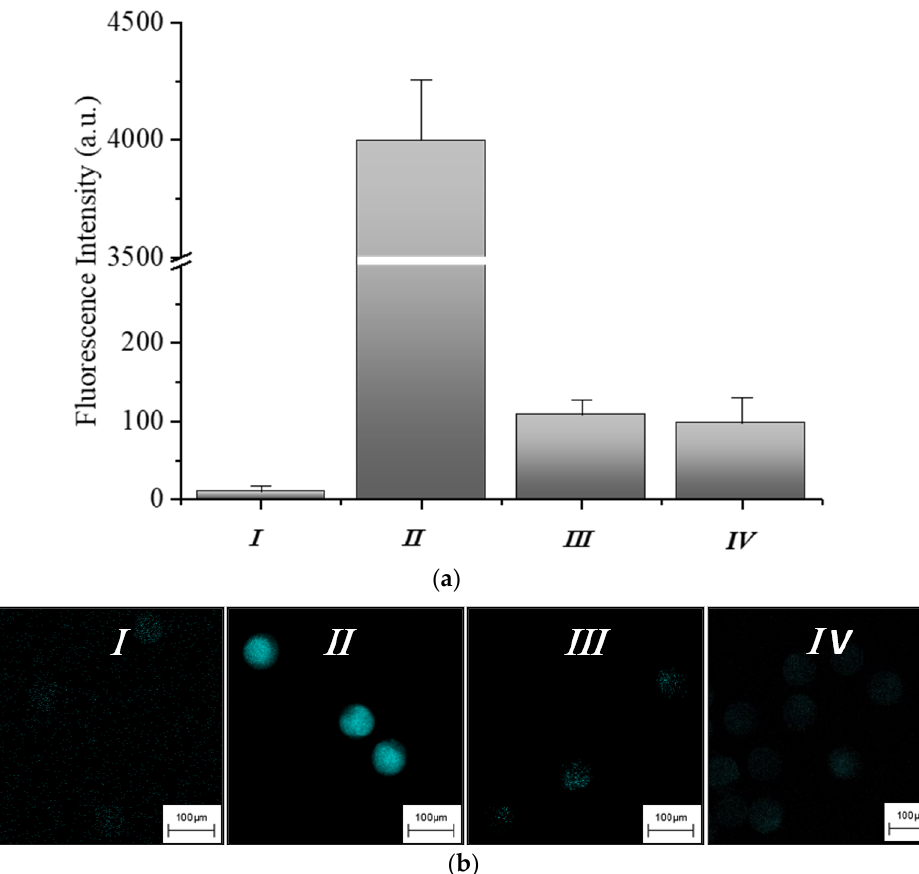
Figure 3. ( a ) Fluorescence intensity measured during the hydrogel-based assay setup and ( b ) the corresponding CLSM images. In particular, the figure shows the fundamental steps involved in target detection: (I) after the synthesis of functionalized hydrogel; (II) when the fluorescent DNA strand was added; (III) in presence of the target in hybridization buffer and (IV) after target hybridization in human serum.